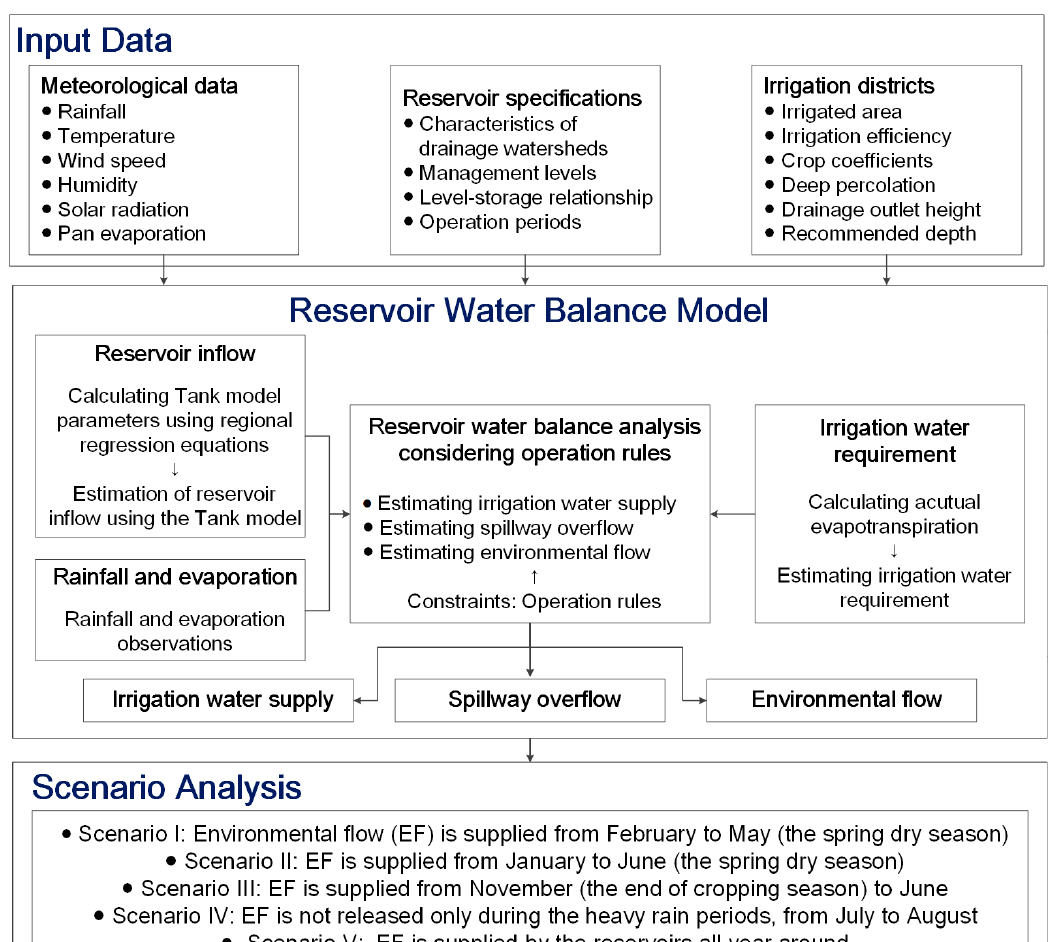
Figure 1. The procedure of the water balance analysis to evaluate the alternative environmental flow (EF) supply scenarios.